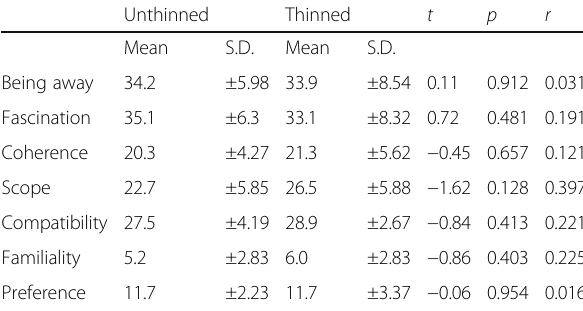
Table 6 Results of t -test comparison between unthinned and thinned settings (Perceived Restorativeness Scale) Unthinned